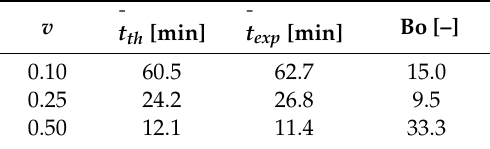
Table 1. Theoretically and experimentally determined mean residence times and bodenstein (Bo) numbers for the three test flow velocities going through an HPLC column (20 cm × 0.8 cm) packed with a loofa sponge.